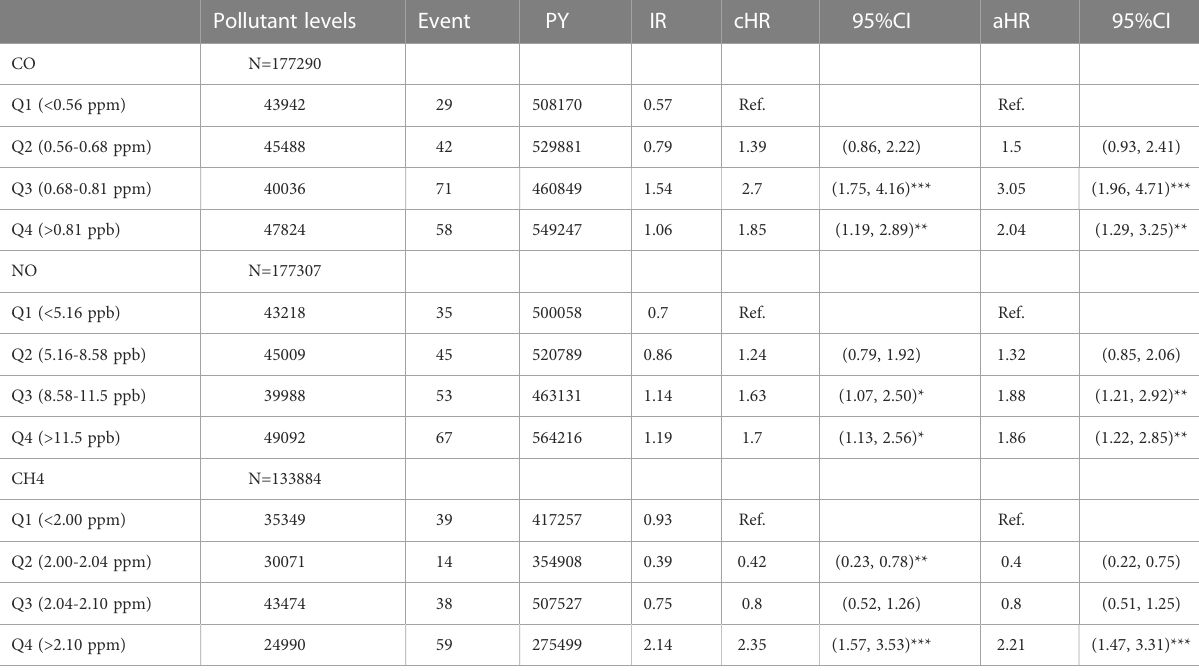
TABLE 2 Incidence and risk of pSS in participants exposed to CO, NO, and CH 4 . Pollutant levels